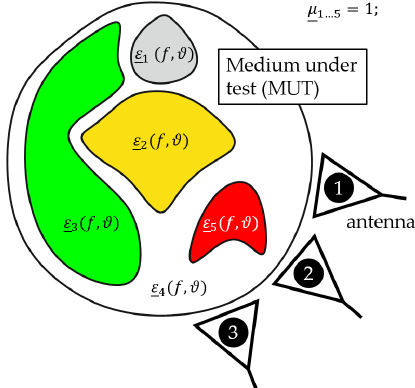
Figure 1. Generic temperature monitoring setup for medical